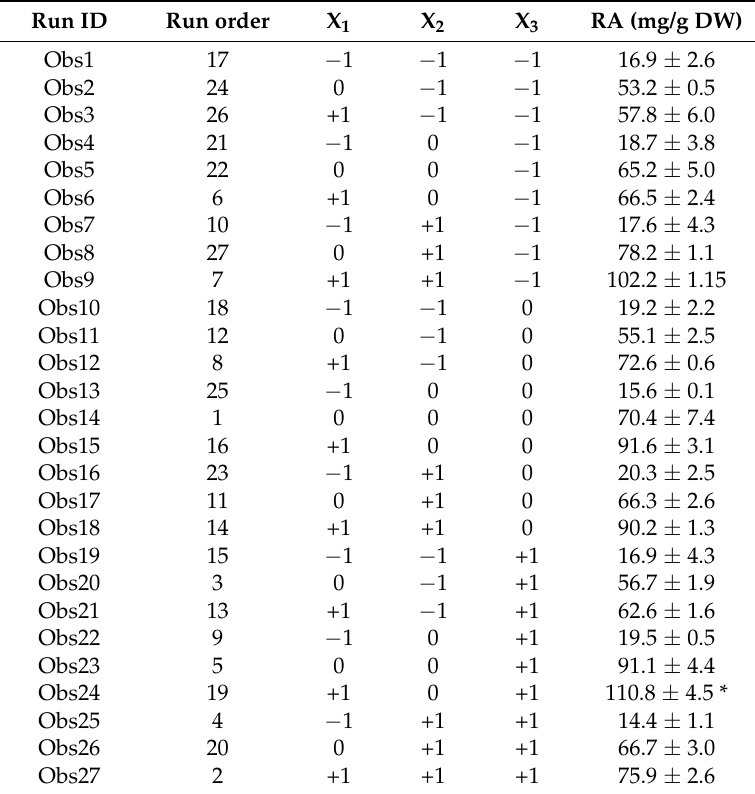
Table 2. Results of experimental